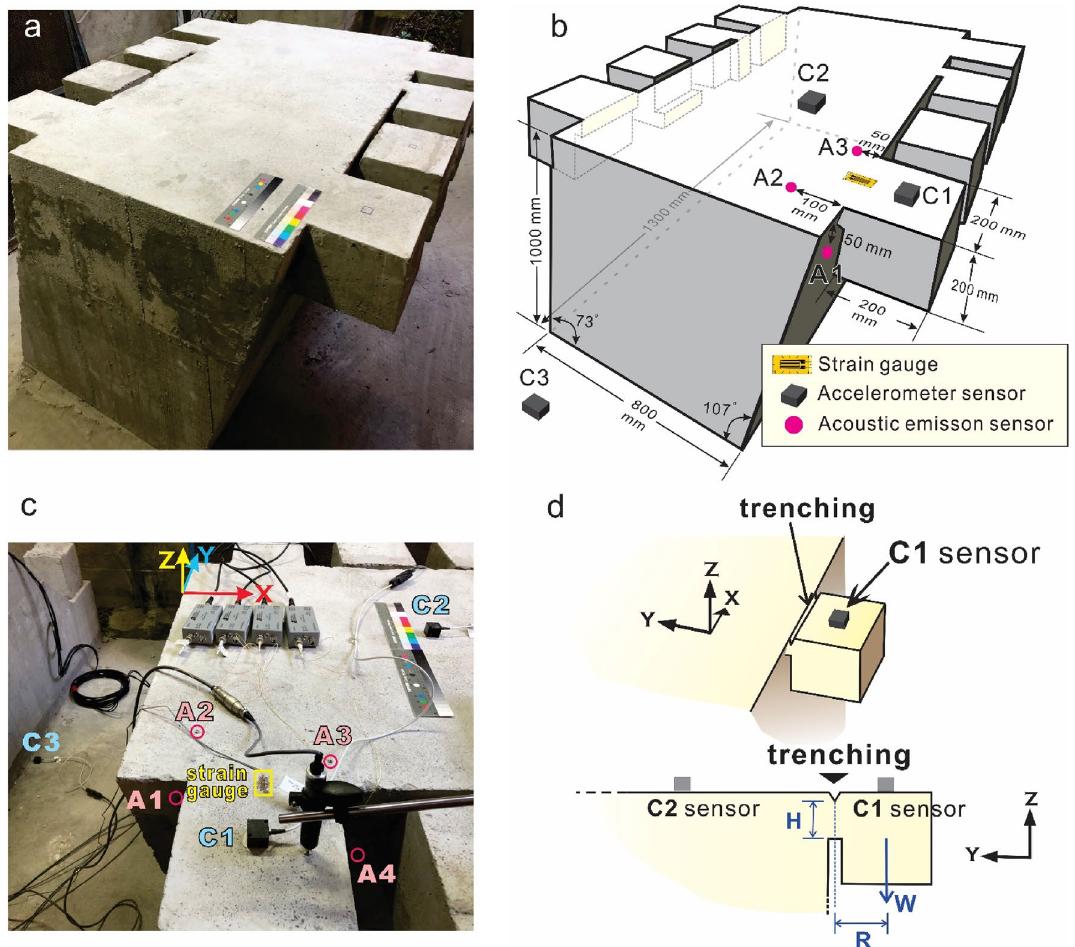
Figure 2. Physical rockfall experiment. ( a ) Photograph of concrete specimen. ( b ) Three-dimensional sketch of the physical rockfall experiment. ( c ) Locations of the accelerometers (C1–C3), strain gauge, linear variable differential transformer and acoustic emission sensors (A1–A4). ( d ) Oblique and side views of the artificial trenches between the main block and overhanging block, which are designed to simulate the bedrock and overhanging rock wedge,